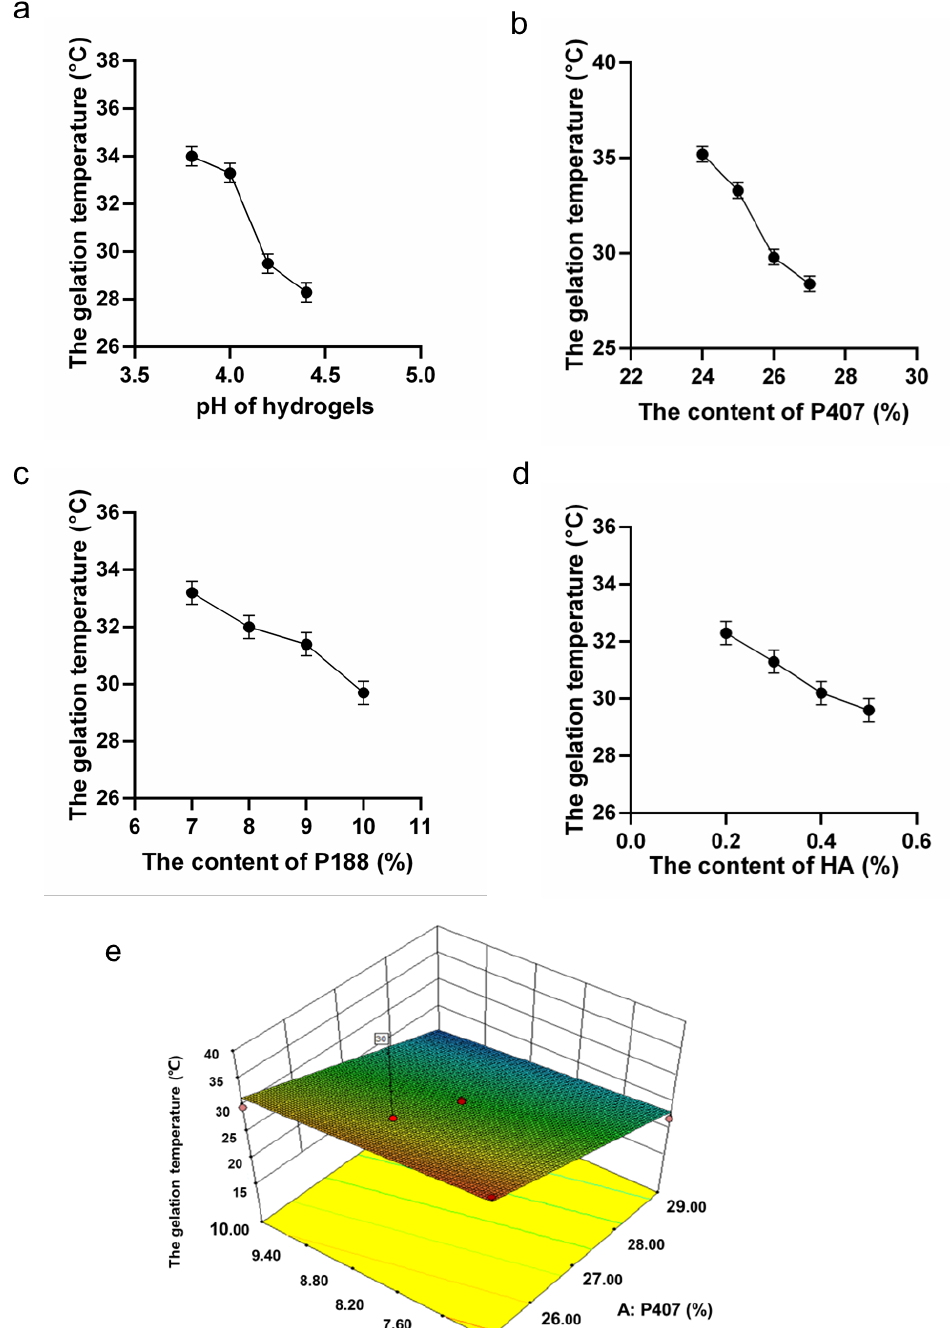
Figure 1. Formulation optimization by RSM test. ( a ). The lactic acid/sodium lactate buffer’s (0.01 M) pH effect on the gelation temperature (Mean ± SD, n = 3). ( b ). The effect of P407 on the gelation temperature. ( c ). The effect of P188 on the gelation temperature. ( d ). The effect of HA on the gelation temperature. ( e ). The 3D image of the response surface optimization model.